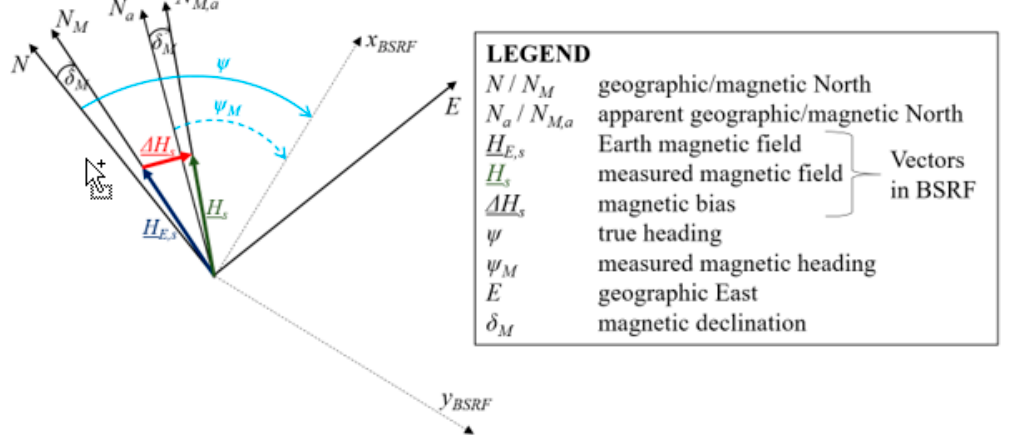
Figure 1. Effect of onboard magnetic sources on the magnetic heading estimation process. They cause the heading angle to be estimated with respect to an apparent geographical North rather than the true North direction. Please note that the figure is not in scale and the sizes of the vectors are chosen for the sake of clarity.